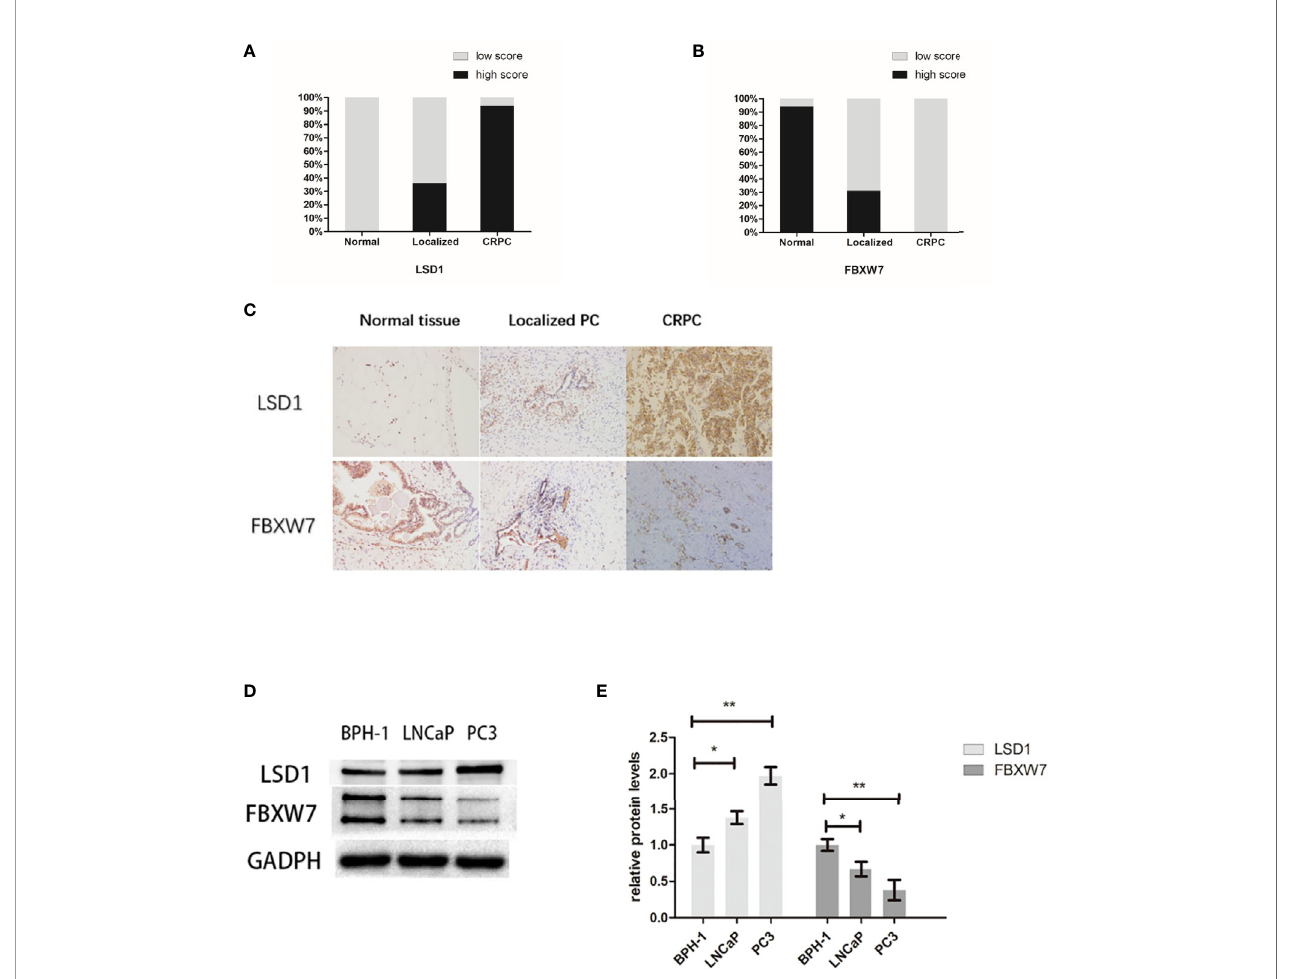
FIGURE 1 | LSD1 expression is up-regulation while FBXW7 expression is down-regulation in PCa. (A, B) Proportions of high intensity scores of LSD1 and FBXW7 IHC staining in normal prostate tissues (n=52), localized PCa (n=36), and CRPCa (n = 16) samples are shown. (C) Representative IHC images of expression levels of LSD1 and FBXW7 in three different tissues. (D) Representative Western blot analysis of LSD1 and FBXW7 in indicated cell lines. (E) Relative protein levels of LSD1 and FBXW7 (compared with BPH-1 cells). Values are expressed as the mean ± SEM.*P < 0.05, **P<0.01, normalized by GADPH, relative to the BPH-1 group, n = 3.